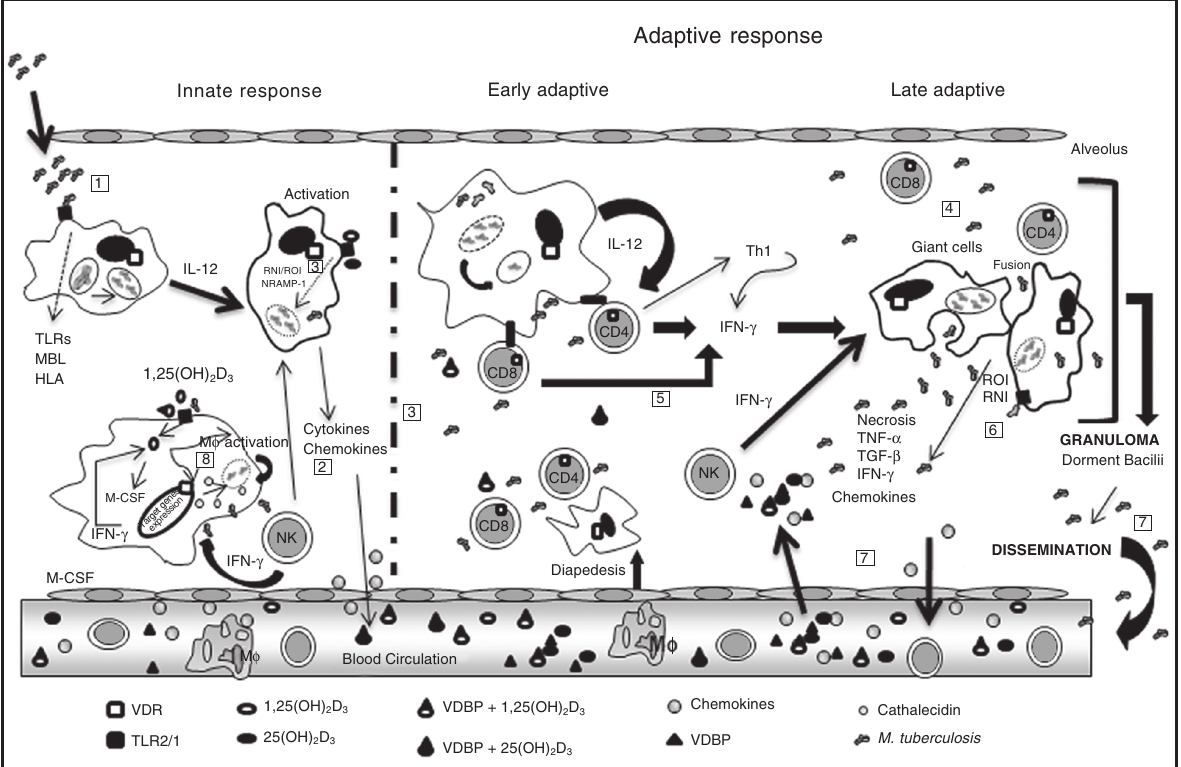
Figure 1. Scheme of the innate and adaptive immune response phases against mycobacteria. The figure identifies all